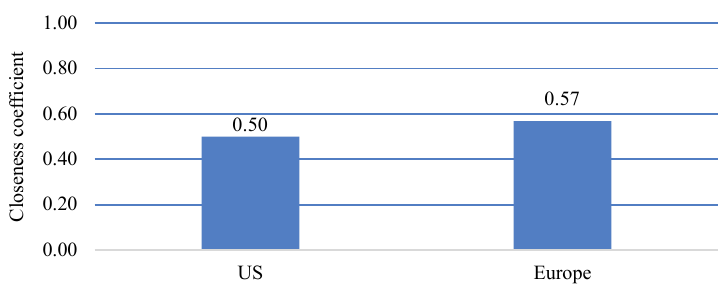
Fig. 4. Results of the TOPSIS analysis at the same criteria